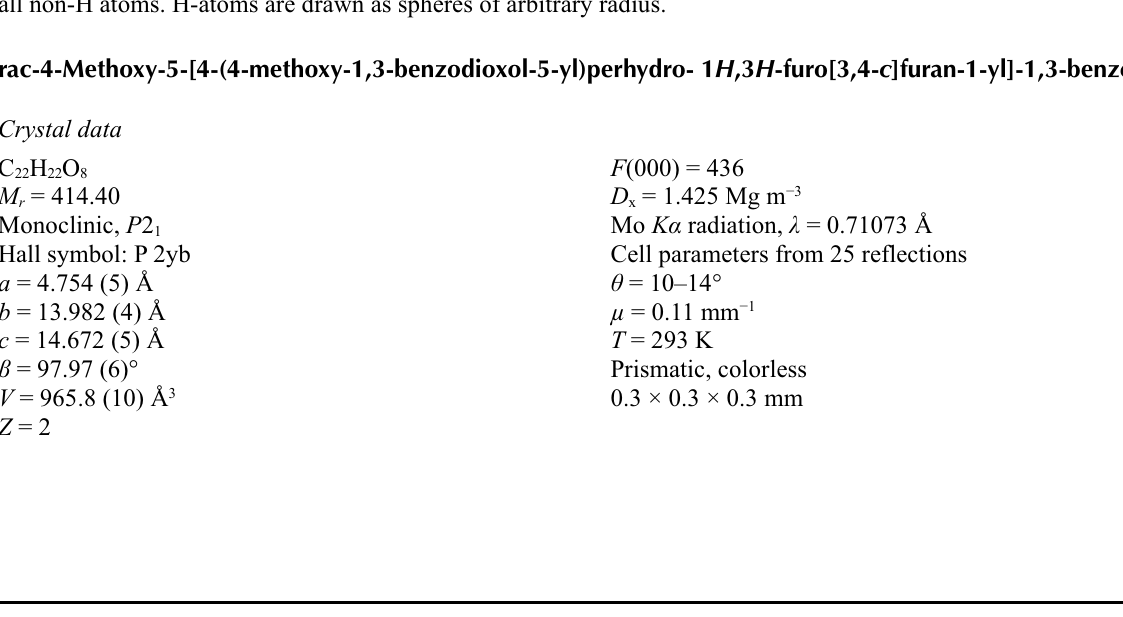
The asymmetric unit of (I) with the atoms labelled and displacement ellipsoids depicted at the 50% probability level for all non-H atoms. H-atoms are drawn as spheres of arbitrary